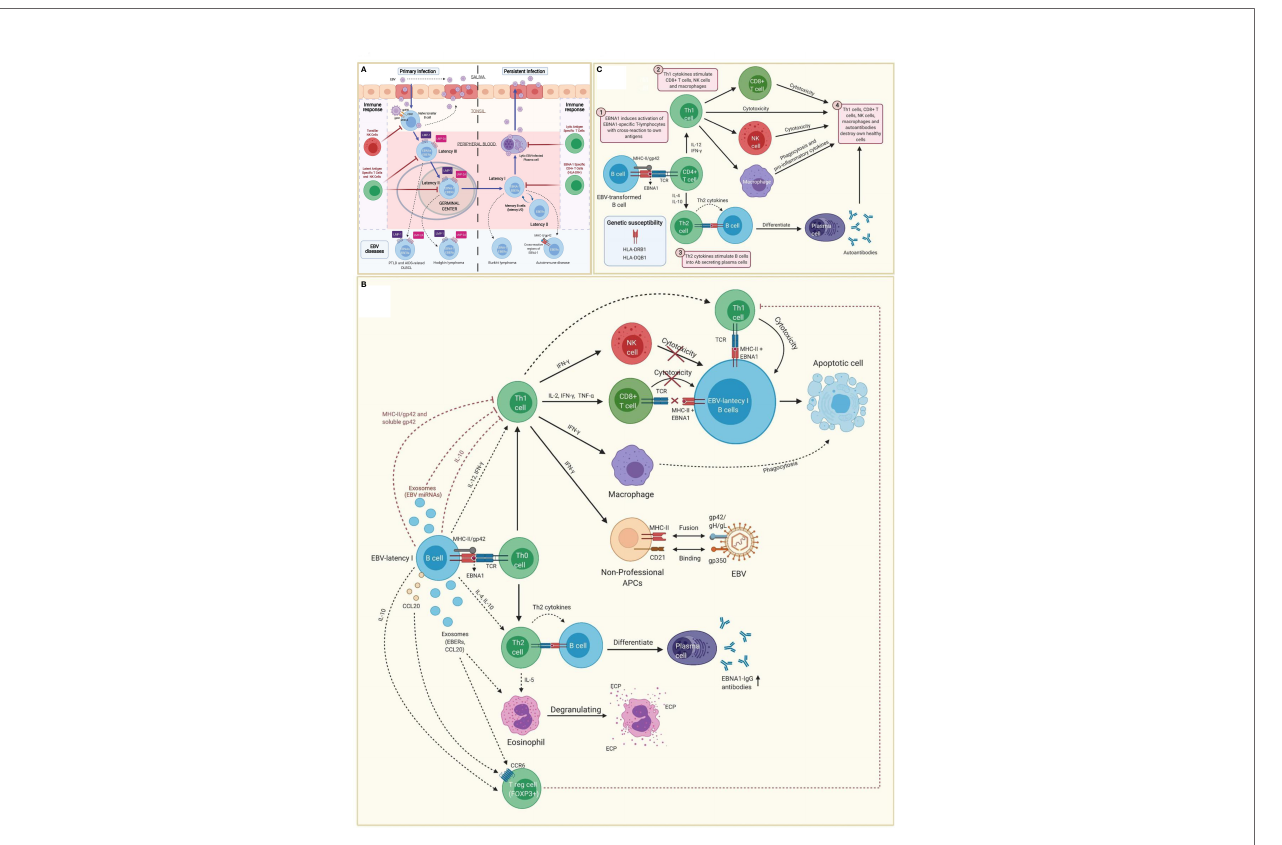
FIGURE 1 | Immunopathobiology of Epstein-Barr virus (EBV) infection. (A) EBV is transmitted to the host through saliva from a carrier individual, and infects pharyngeal epithelial cells followed by naïve tonsillar B cells through interactions between gp350 and gp42 glycoproteins of the viral envelope with CD21 and MHC class II molecules (MHC-II), respectively. Lytic infection produces new viral particles that infect more epithelial cells. Subsequently, these EBV-infected B cells enter into a latency phase in the periphery, where they express a speci fi c set of viral genes, including LMP1, LMP2A, EBNAs and EBER (latency III). These latent III B cells progress through the germinal center reaction into latency II and emerge as memory B cells with I/0 latencies that establish a lifelong latent infection. The immune response of the healthy host is suf fi cient to maintain control of the EBV infection. NK cells in tonsil produce high levels of IFN- g that withhold the transformation of B cells by EBV during earlier stages of the infection. Both, type III and type II latent B cells are controlled by NK and T cells speci fi c to latent proteins. By contrast, memory B cells with type I latency are only controlled by activated EBNA-1 speci fi c CD4 T cells. EBV-infected plasma cells can periodically enter in lytic phase, but are controlled by CD4 and CD8 T cells with speci fi city for EBV lytic proteins. The programs of the viral latent cycle are expressed in various EBV-associated diseases. Latency I is found in Burkitt lymphoma, latency II in Hodgkin lymphoma and latency III in post-transplantation lymphoproliferative disease (PTLD) and AIDS-associated diffuse large B-cell lymphoma (DLBCL). EBV-latency I B cells escaping the surveillance of EBNA-1-speci fi c CD4 T cells could lead to autoimmunity by presenting EBNA-1 in MHC-II/gp42, which may cause cross-reaction with own antigens. (B) EBNA1 is presented to CD4 T cells on MHC class II molecules in EBV-infected